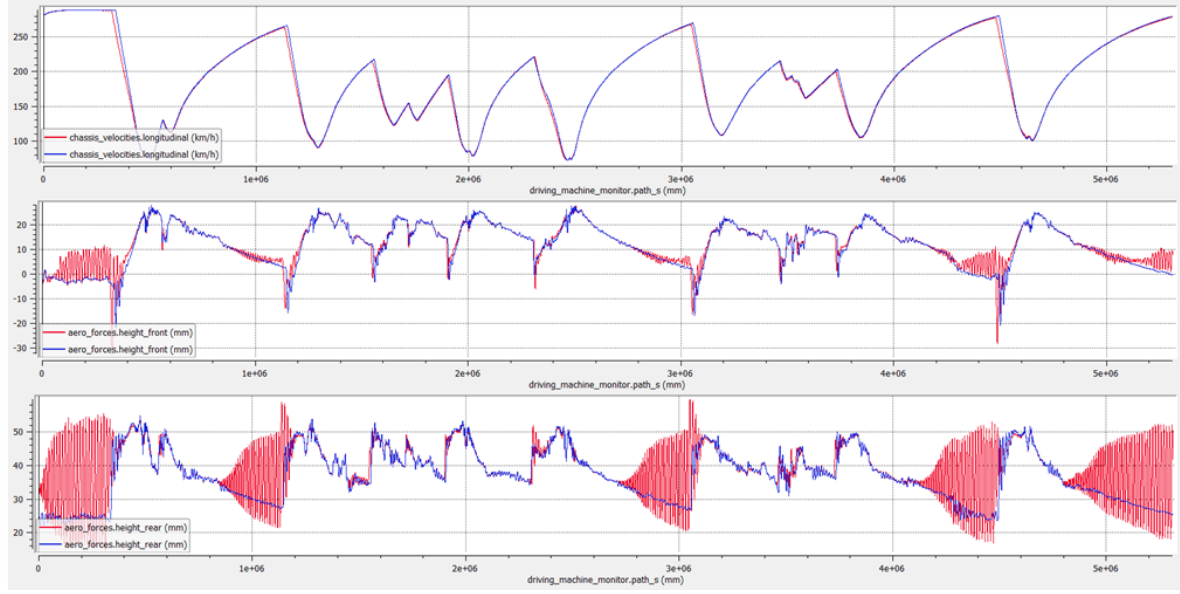
Figure 32. Baseline setup (blue, #1) vs. model with decay functions/porpoising (red, #2). Top plot is the speed profile vs. lap distance, mid and bottom plots are the front and rear ride heights.